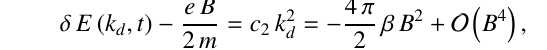
Figure 2. E ff ective energy shift Euclidean-time fits (a) and the linearly constrained quadratic fit for the m π = 570 MeV proton